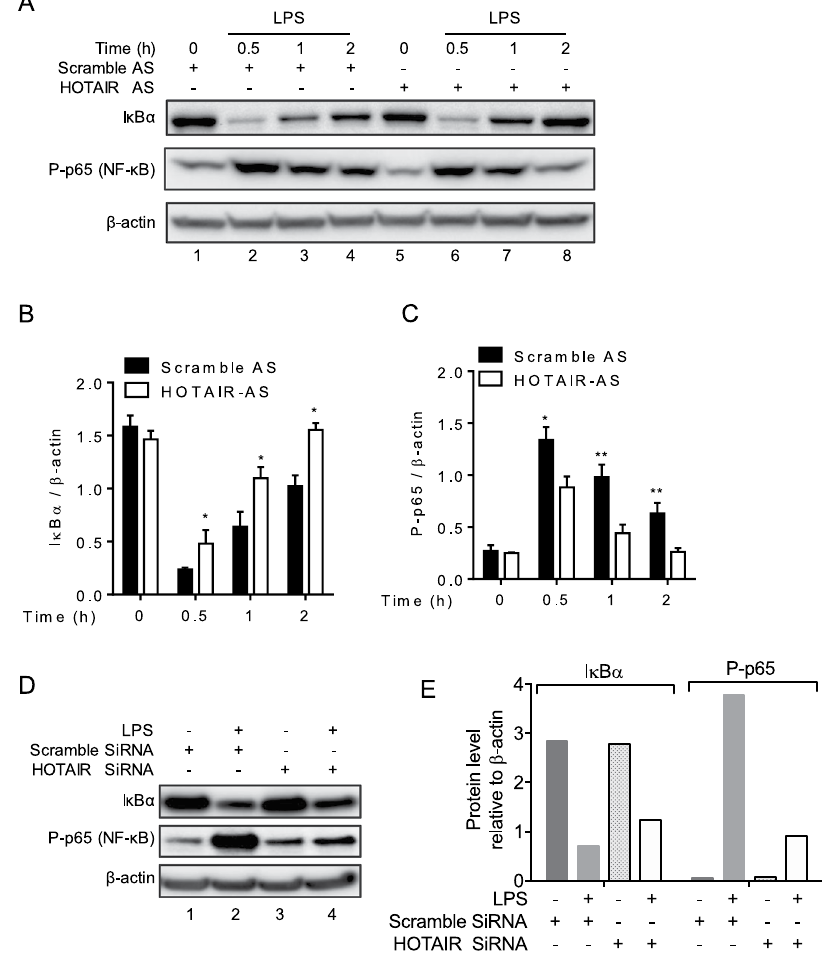
Figure 4. HOTAIR promotes I κ B α degradation thereby activates NF- κ B. ( A – C ) Antisense-mediated knockdown of HOTAIR followed by LPS-treatment. RAW264.7 macrophages were transfected with HOTAIR- or scramble antisense for 48 h, treated with LPS for different time periods (0.5 h, 1 h and 2 h) and protein was isolated. The protein was resolved on SDS-PAGE and immunoblotted with antibody against I κ B α , phospho p65 (NF- κ B subunit) and β -actin (loading control). The changes in amounts of I κ B α and NF- κ B have been quantified by ImageLab5.2.1 software ( B , C ). ( D , E ) siRNA-mediated knockdown of HOTAIR followed by LPS-treatment. Proteins from HOTAIR- or scramble siRNA (48 h-treatment) followed by LPS (1 h) -treated RAW264.7 were analyzed by Western blot using antibody against I κ B α , phospho p65 and β -actin. Quantifications (ImageLab5.2.1software) are shown in panel E. Data represent mean ± SD; * p < 0.05, ** p <